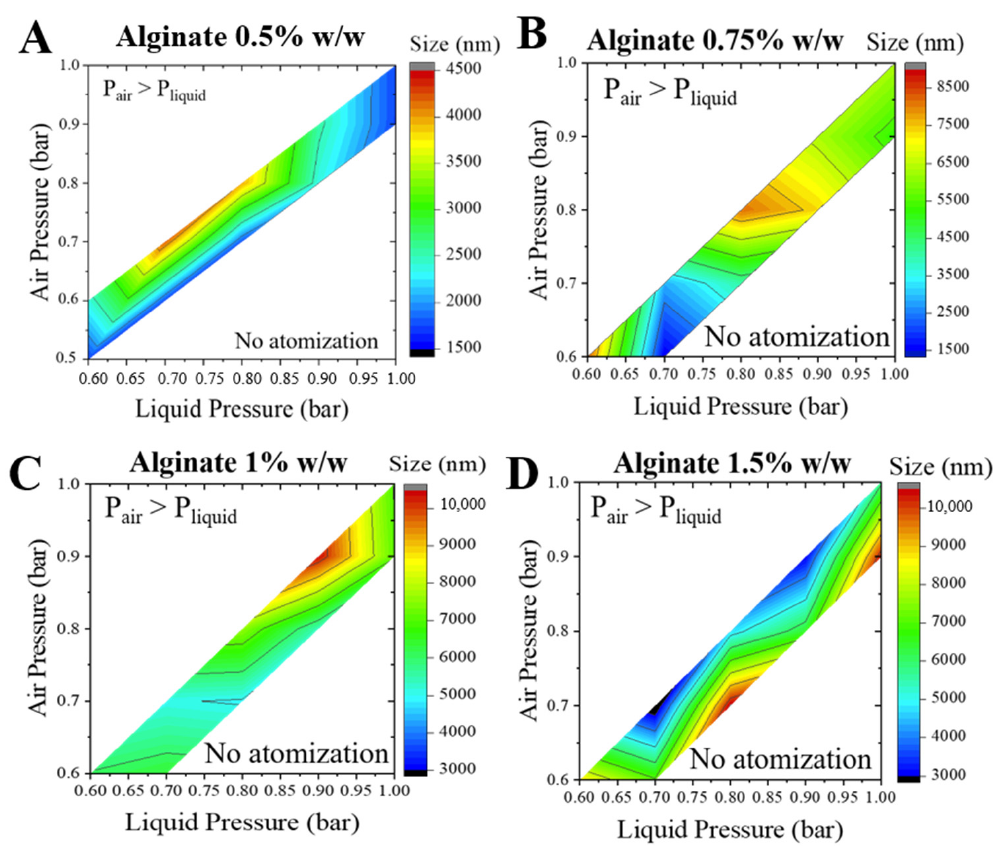
Figure 5. Alg-Ppz MPs. Air and liquid pressures influence on particle size diameter for different alginate concentrations; ( A ) 0.5% w / w ; ( B ) 0.75% w / w ; ( C ) 1.0% w / w ; ( D ) 1.5% w / w .